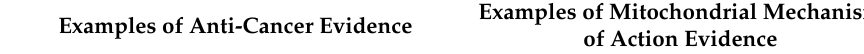
Table 2. Phytochemicals that Display Anti-Breast Cancer Potential Via